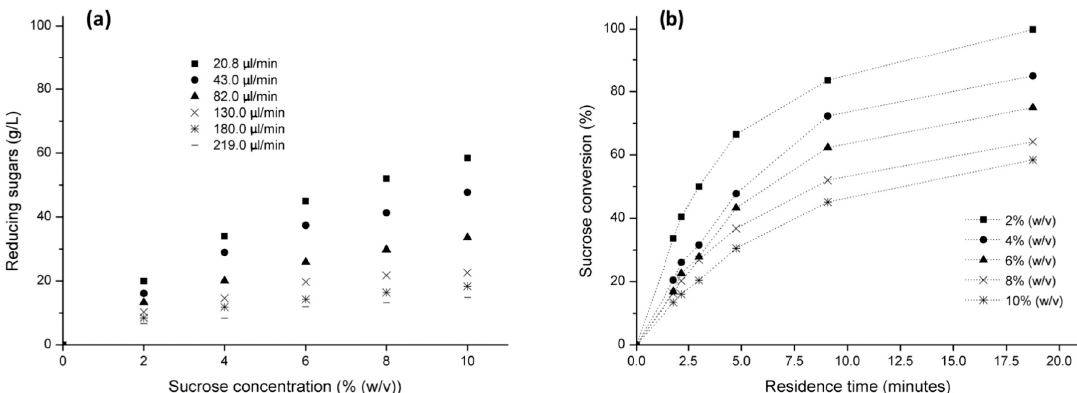
Figure 4. Bioconversion in the microchannel reactor using flow rates in the range of 20.8 to 219.0 µ L · min − 1 ( a ); and substrate concentrations ranging from 2.0% to 10.0% ( w / v ) ( b ).